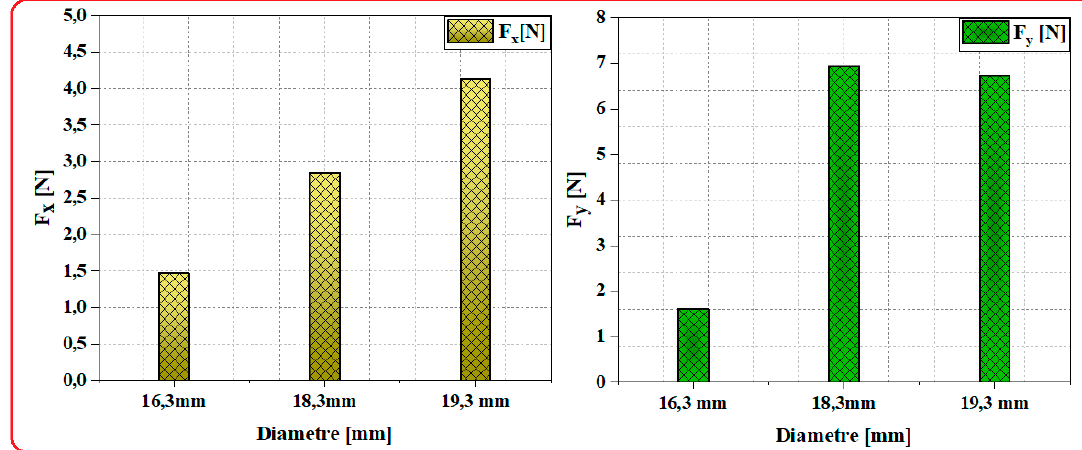
Figure 15. Evolution of F x and F y .